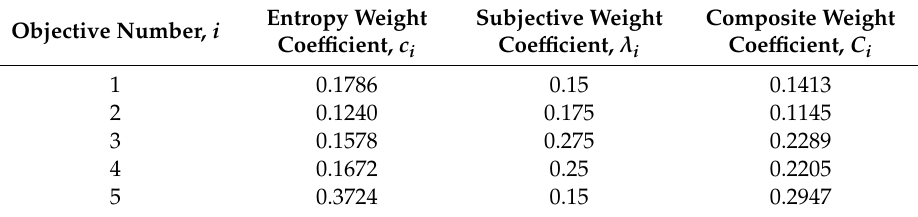
Table 7. The weight coe ffi cients of